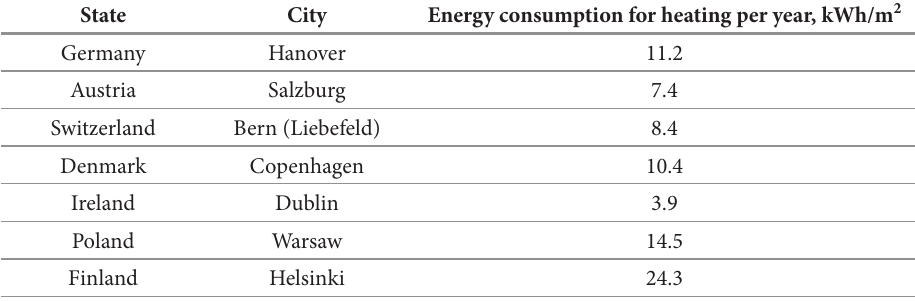
Table 3. Heating energy consumption depending on climate